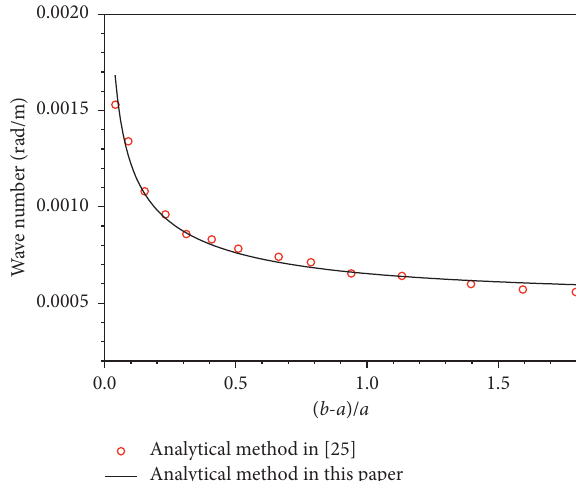
Figure 2: Wave number of an insulated antenna in an anisotropic ionosphere versus the normalized insulation